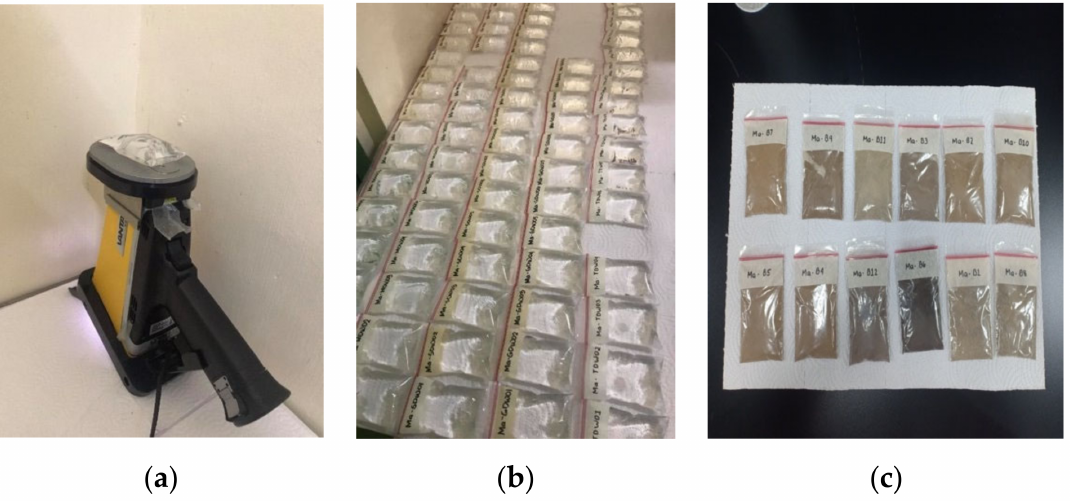
Figure A1. Setup of heavy metal testing of surface water and soil using the portable XRF. ( a ) is the portable XRF, ( b ) water samples, and ( c ) soil